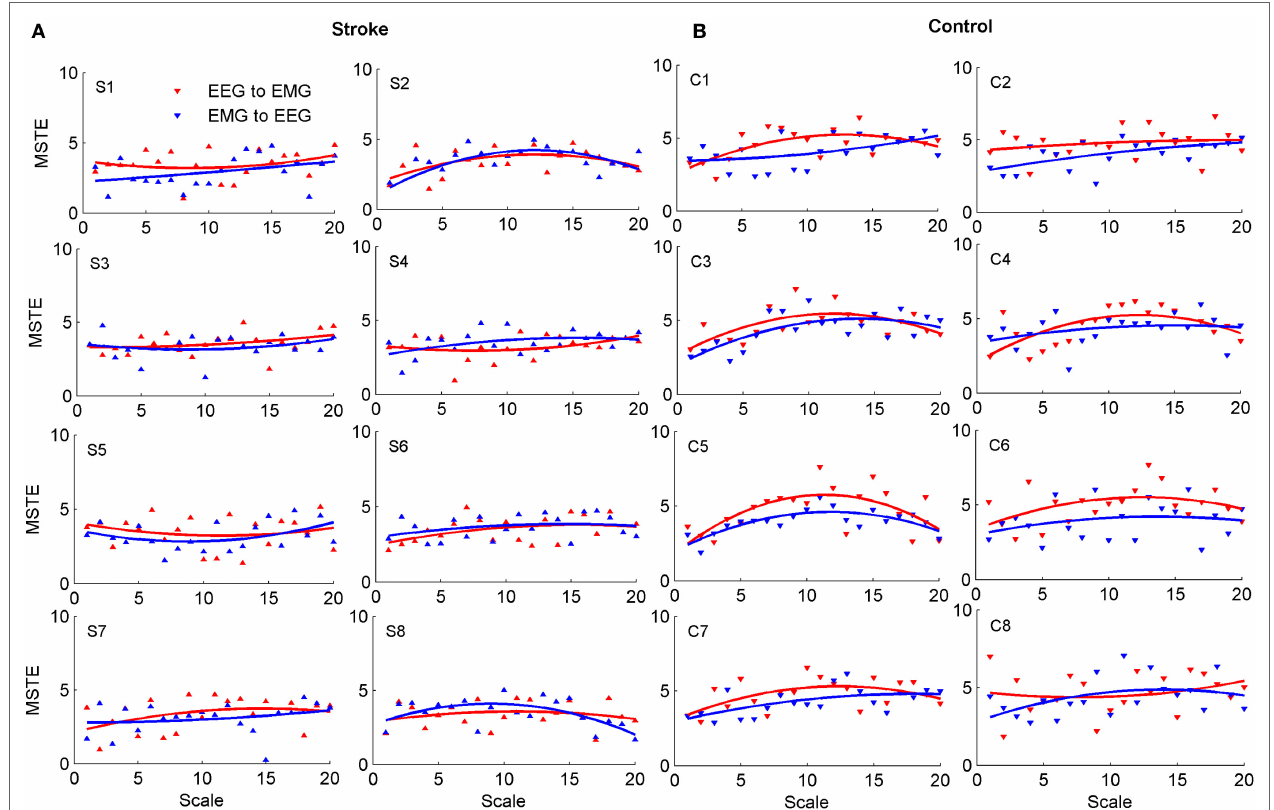
FIGURE 2 | The MSTE values in descending and ascending directions for both stroke patients and healthy controls, respectively. (A) Showed the MSTE values in two directions for each stroke patient and (B) for each healthy control. The label “S” in (A) represented the stroke patient, and the label “C” in (B) meant the healthy